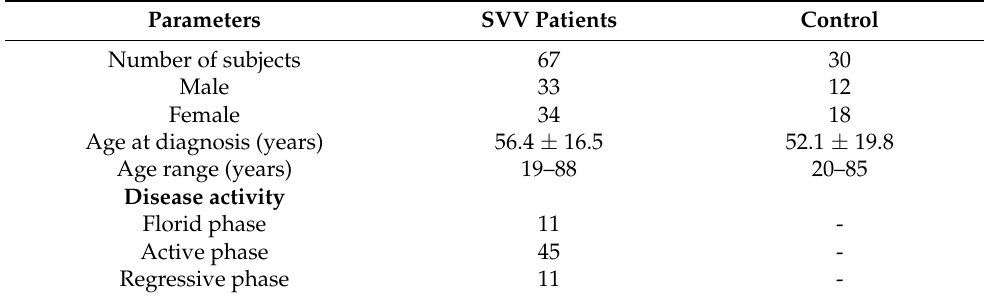
Table 1. General characteristics of subjects whose skin biopsies were analyzed for the presence of acrolein–protein conjugates.